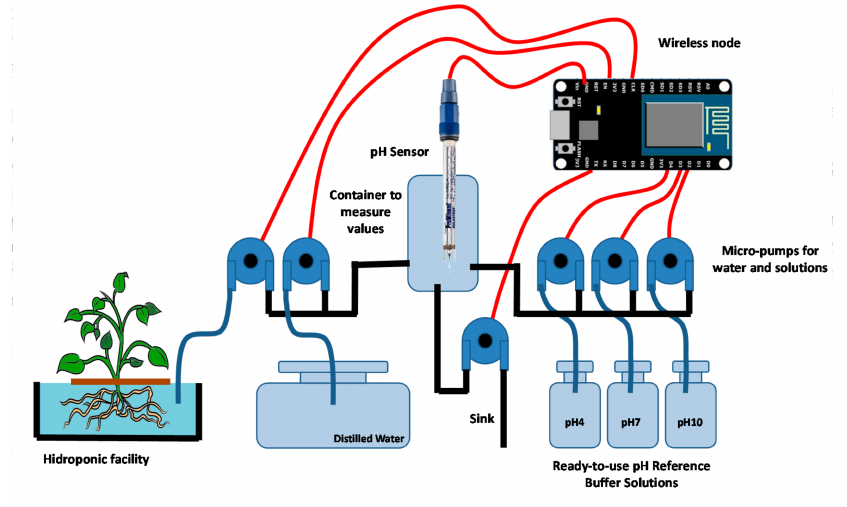
Figure 1. Auto-calibrated pH sensor and wireless